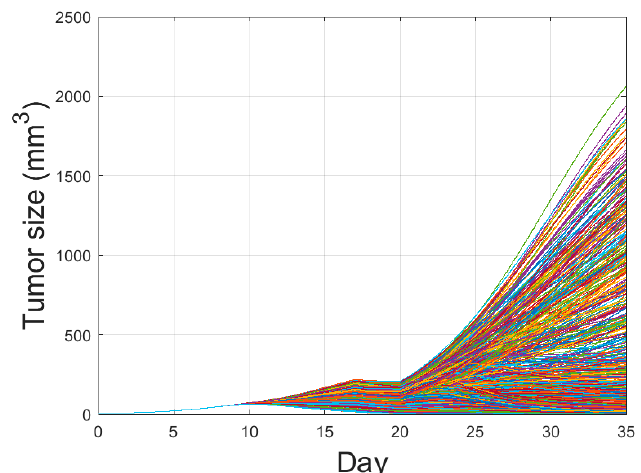
Figure 5. Tumor growth curve with combination therapy of IR and IT is plotted with the parameter variations using Latin Hypercube Sampling. One thousand cases with four parameters randomly extracted from (7) were conducted. By varying these parameters, some tumors are eliminated, some reach maximal tumor sizes, and the others are in between the two extremes. The amount of combination therapy and other parameter values were unchanged except for η , ν , µ , and k el .